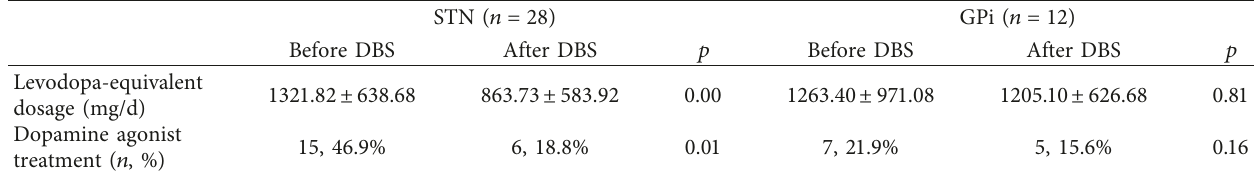
Table 3: Patient medication characteristics before and after DBS.